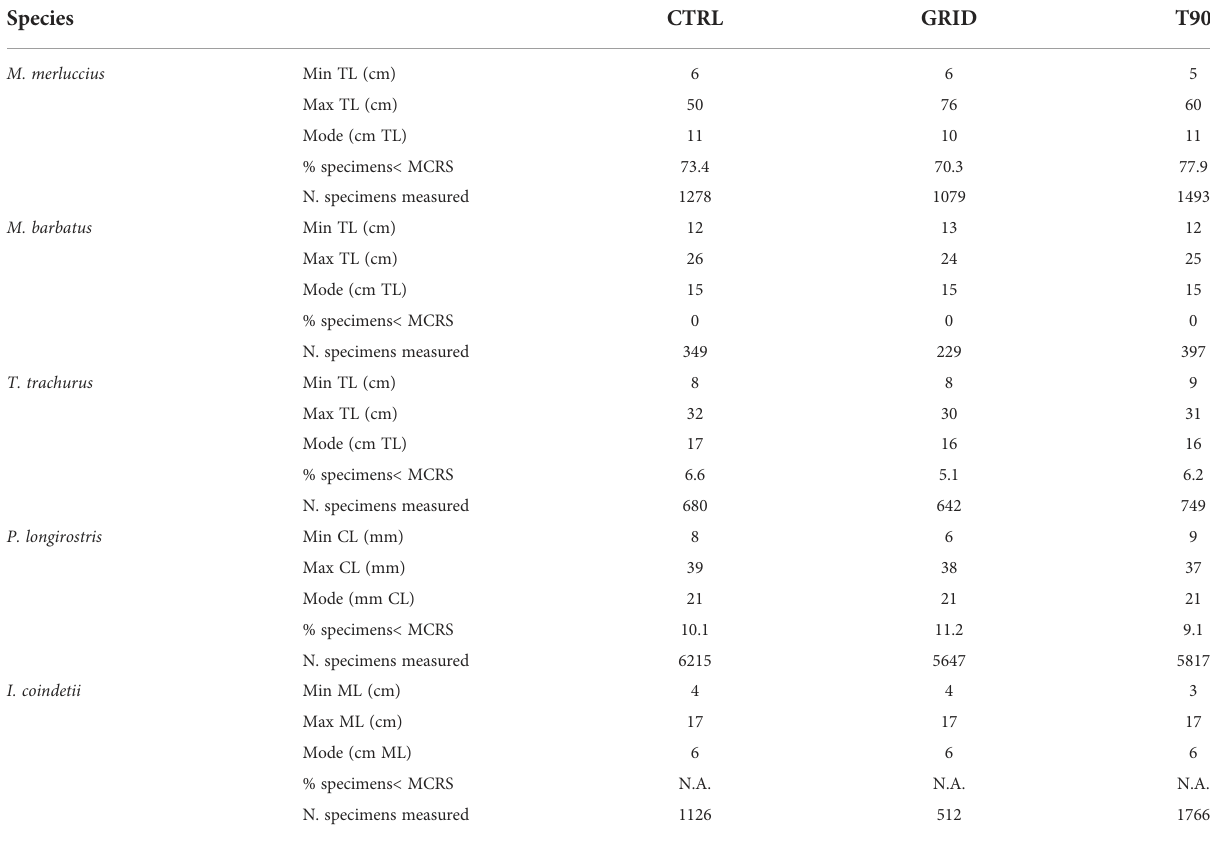
TABLE 3 Summary of the length frequency distributions of the target species.